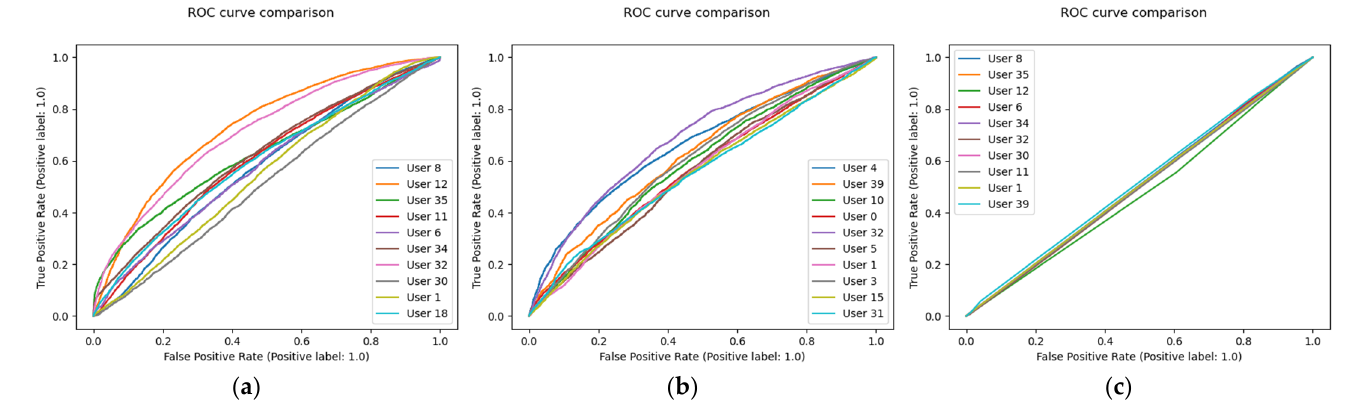
Figure 3. ( a ) RF ROC curve; ( b ) SVM ROC curve; and ( c ) KNN ROC curve.